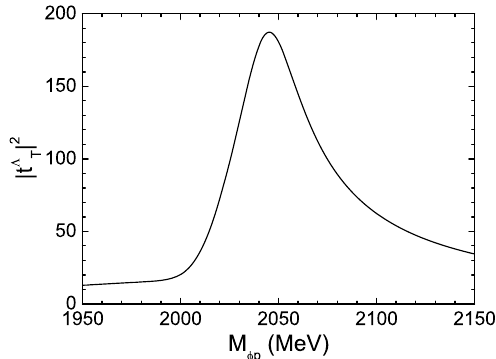
of the process T